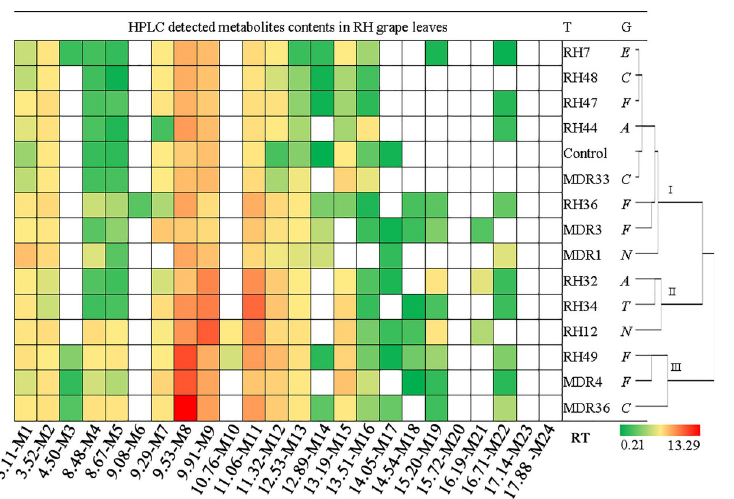
Fig 4. Heatmap and clustering of HPLC-detected metabolite contents in RH grape leaves.